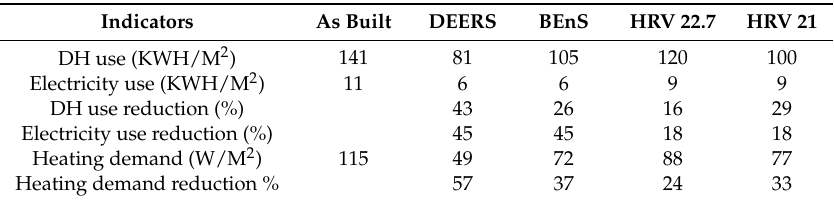
Table 8. Energy use per year for the renovation